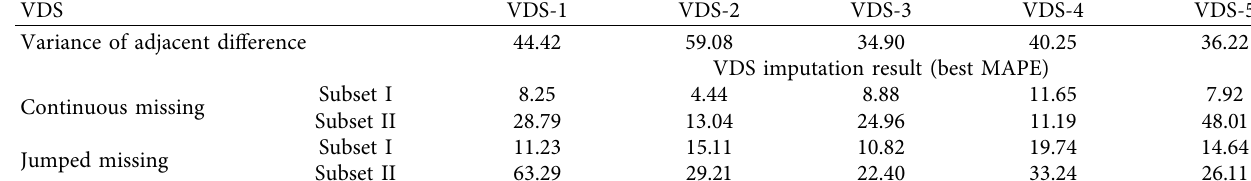
Table 6: Experimental results of simulated imputation.